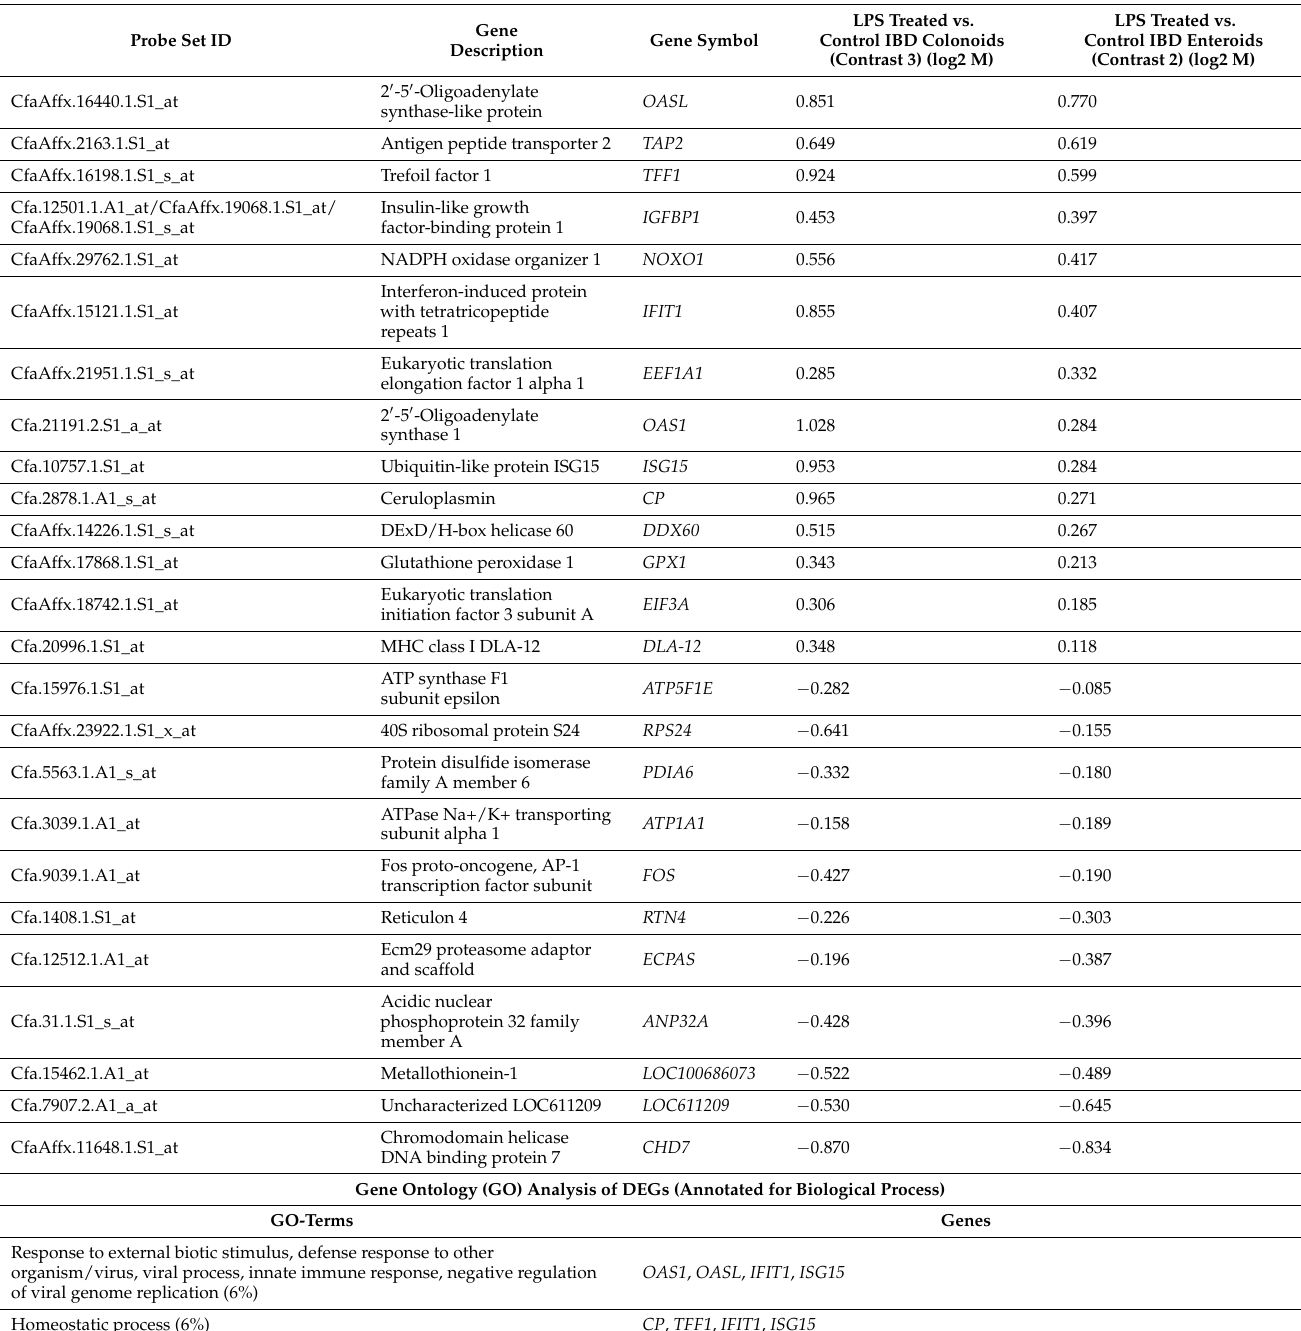
Table 11. The Gene Ontology (GO) analysis and details about the DEGs exhibiting a similar pattern of expression between the IBD enteroids and colonoids following LPS stimulation annotated for the biological process, molecular function, and cellular component categories. The number of genes that fell into each of these categories is shown in